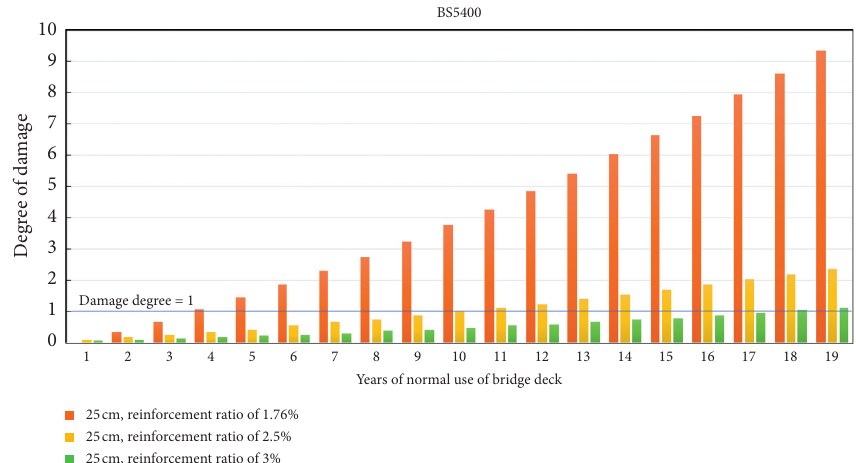
Figure 18: Fatigue damage of bridge-deck reinforcement under three reinforcement ratios with a slab thickness of 25cm.